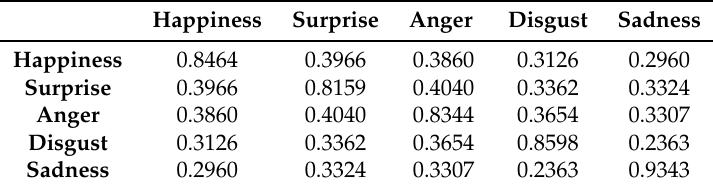
Table 7. Cosine similarity for ResNet8. Happiness Surprise Anger Disgust